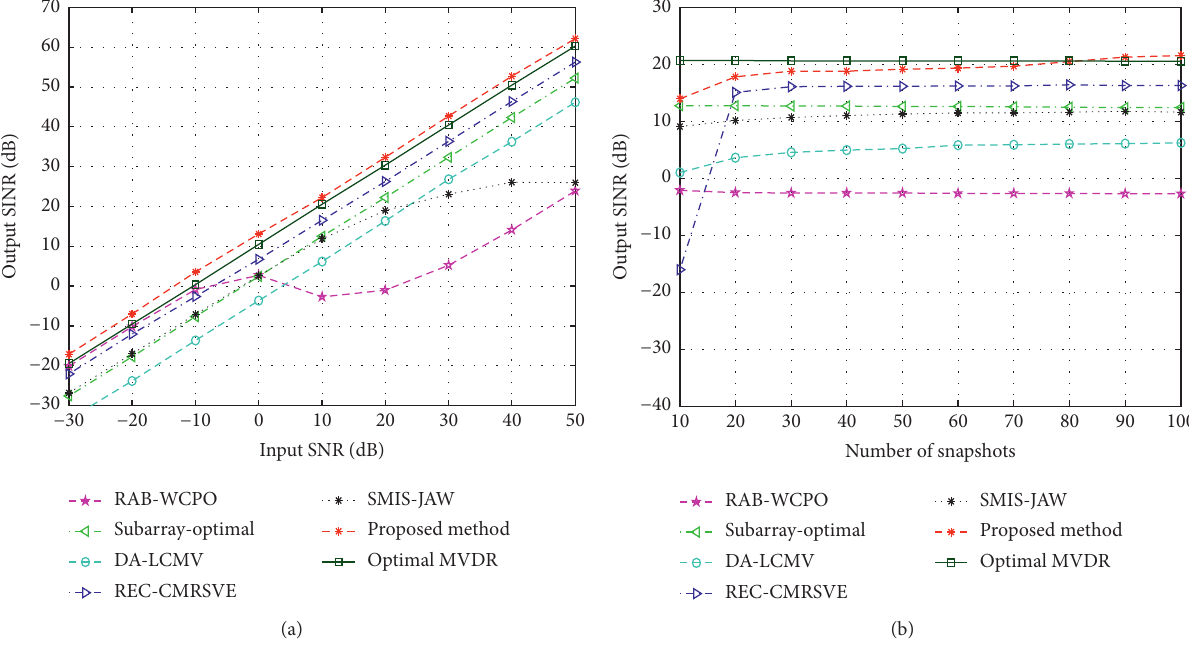
Figure 7: Fourth example: (a) output SINR versus input SNR and (b) output SINR versus number of snapshots.